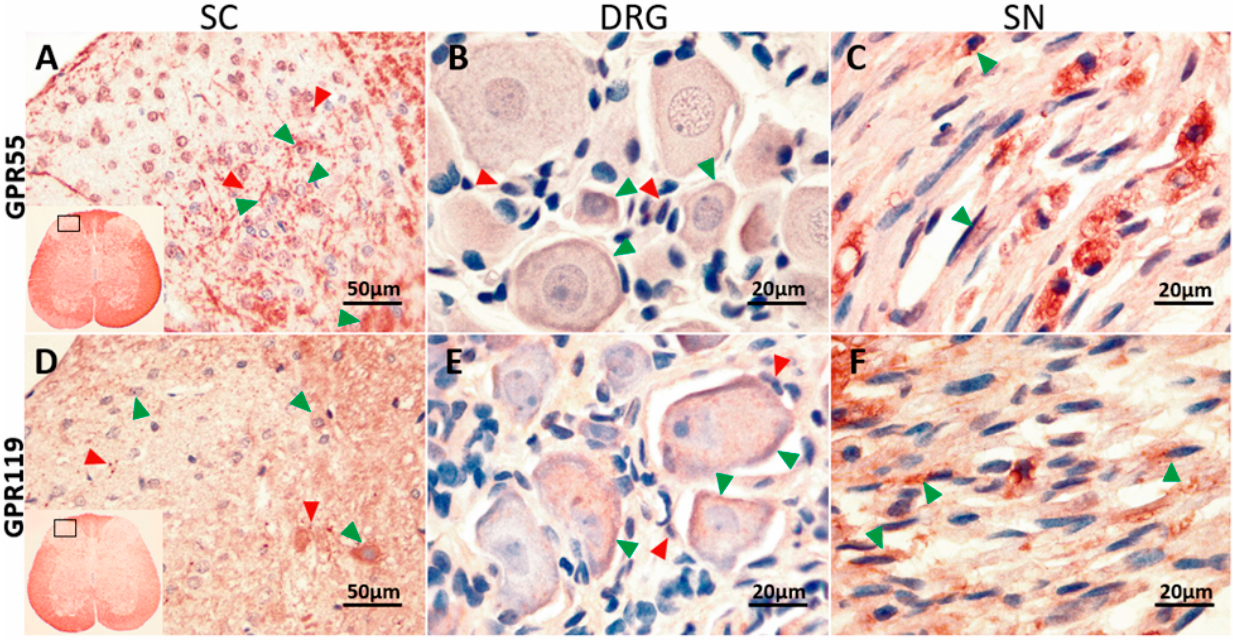
Figure 4. Immunolocalization of GPR55 ( A – C ) and GPR119 ( D – F ) in the left dorsal horn of the lumbar spinal cord (SC), L5-L6 dorsal root ganglia (DRG) and sciatic nerve (SN) from rats by indirect immunoperoxidase staining (labelled streptavidin biotin method). The tissue sections were counterstained with haematoxylin. Green arrowheads indicate the expression of both receptors on some neurons, whereas the red arrowheads indicate the expression on glial cells. The rectangle within small spinal cord inserts ( A , D ) indicate the region where the enlarged images were obtained.